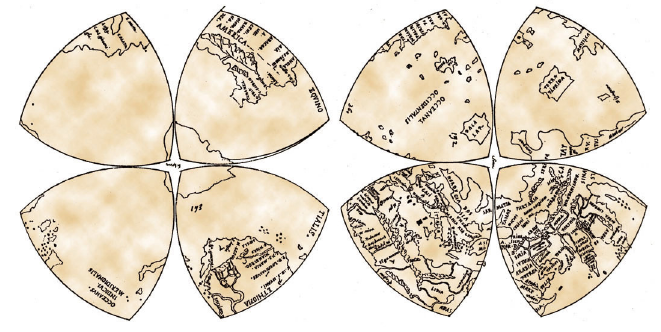
Fig. 10. Da Vinci’s Map of the World (source: